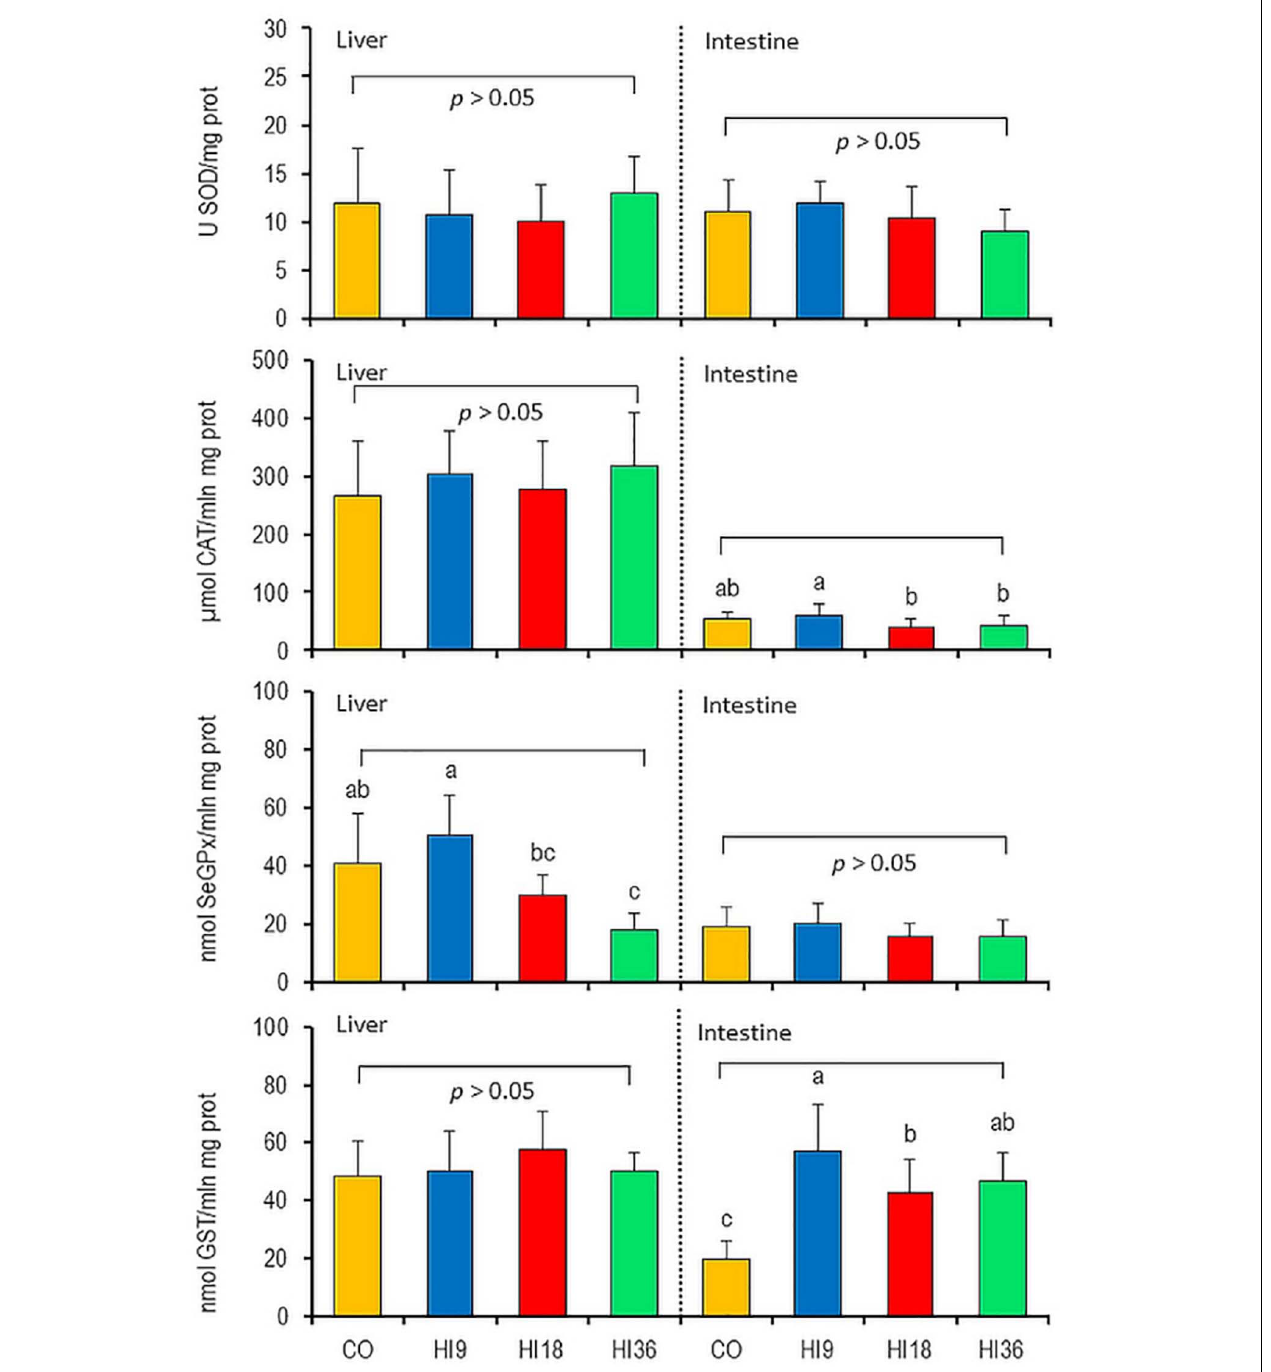
FIGURE 1 | Oxidative biomarkers in liver and intestine of pikeperch ( Sander lucioperca ) fed experimental diets. Values are presented as means ± standard deviation. Means with different letters are significantly different ( P < 0.05) from each other.